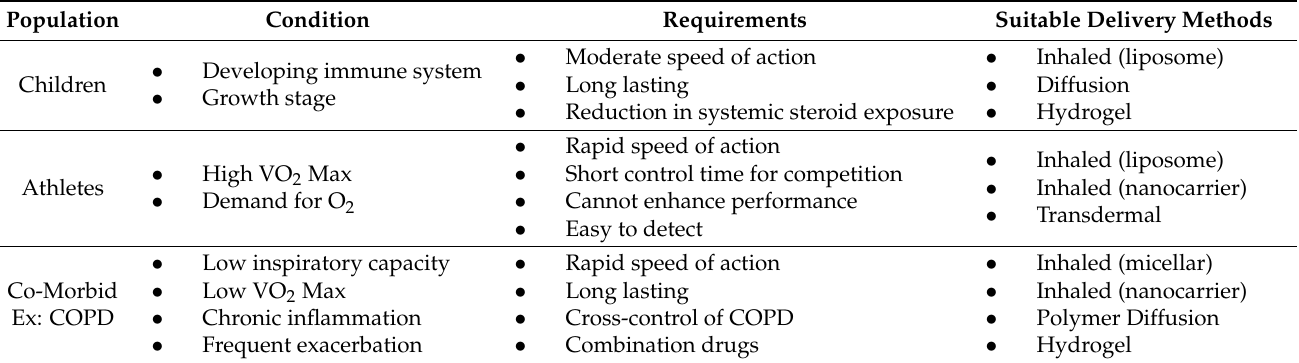
Table 3. Summary of Parameters Needed for Drug Delivery by